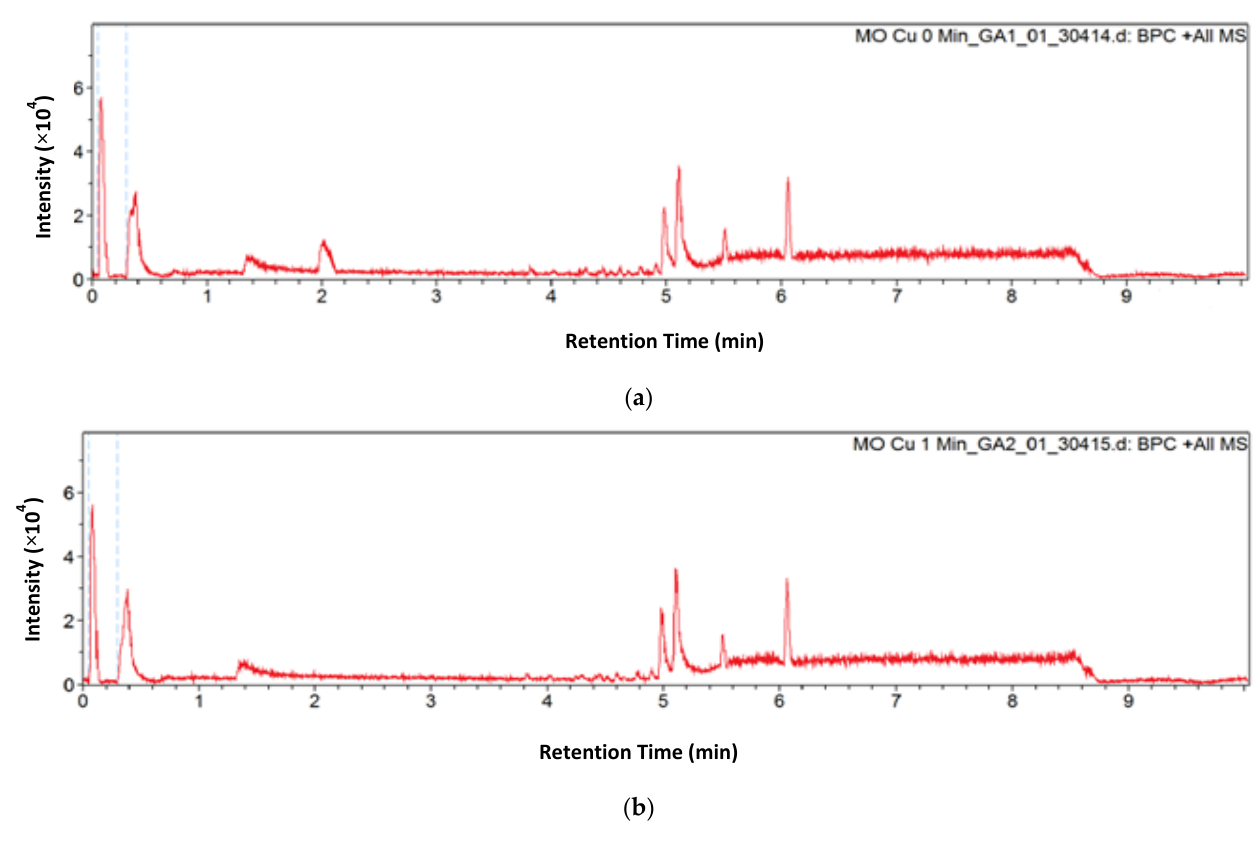
Figure A3. Mass chromatogram of methyl orange solution ( a ) before degradation at 0 min and ( b ) after 1 min degradation by Fe/Cu/Ag 5:1:0.2 nanoparticles.